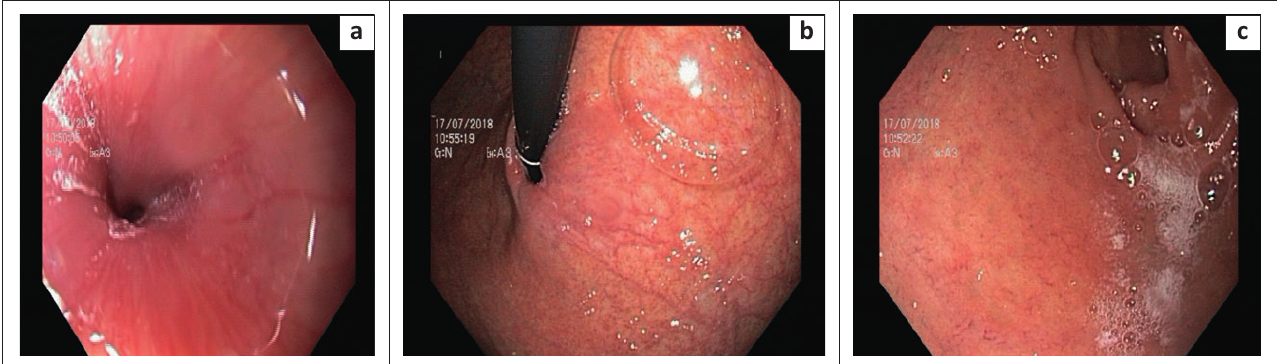
FIGURE 4: (a) Upper gastro-intestinal endoscopy – Shows the dilated proximal esophagus and stenotic lower oesophageal sphincter (b) Difficulty in passing the endoscope beyond the stenosis (c) Pooling of saliva above the stenotic lower oesophageal TABLE 1: Characteristic features of the oesophageal motility disorders. Characteristics